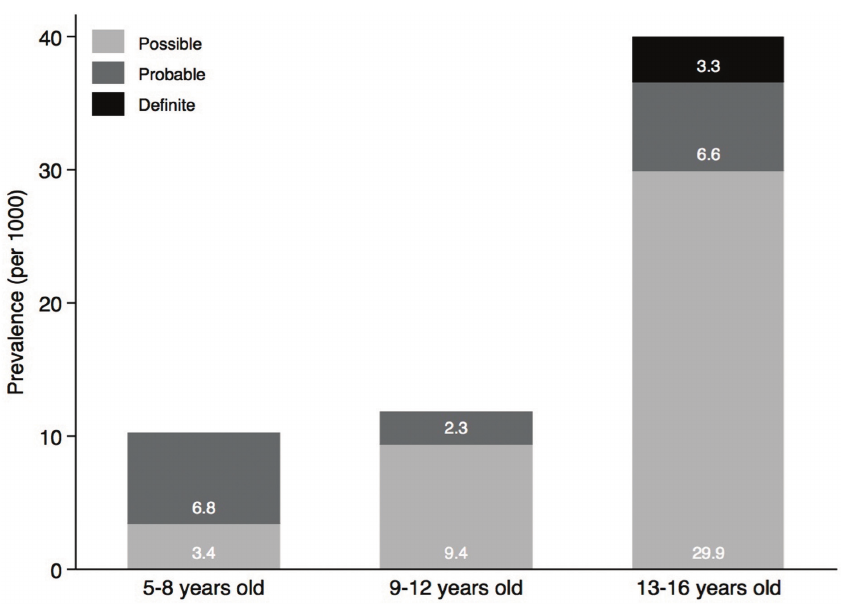
Fig 2. WHO stage of disease according to age categories from 5 to 8 years, 9 to 12 years and 13 to 16 years. Light grey indicated possible RHD, grey indicates probable RHD, and dark grey indicates definite RHD according to the modified WHO classification. The association between RHD according to the modified WHO classification and the age groups was assessed using the χ 2 test (p = 0.010). The association between disease progression and age was evaluated using unweighted ordered logistic regression (p = 0.016) and weighted ordered logistic regression (p = 0.416).